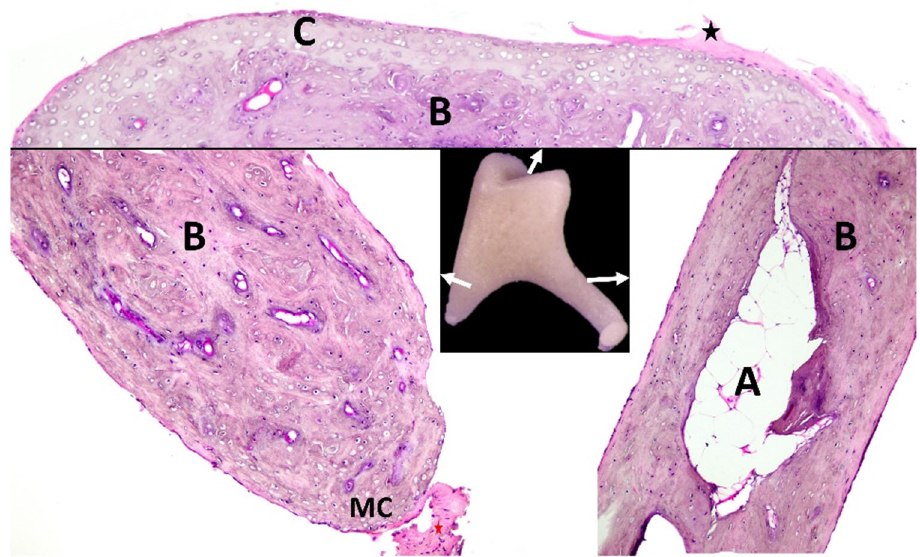
Figure 4. Histological aspects of the incus. Arrows indicate areas selected for histology. A—marrow cavity filled with adipocytes; B—compact bone; C—articular hyaline cartilage; black star—incu ‐ domalleolar ligament; MC—mineralized cartilage with posterior incudal ligament (red star).